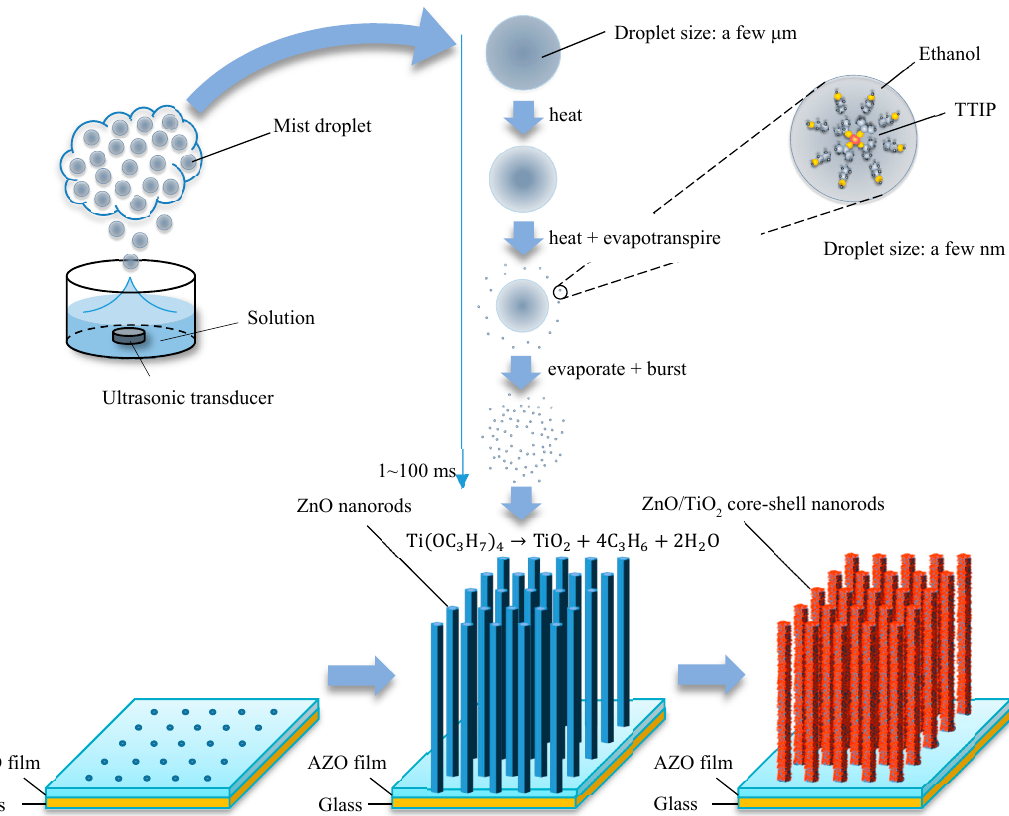
Figure 1. Mechanism of ZnO / TiO 2 core–shell nanorod fabrication.